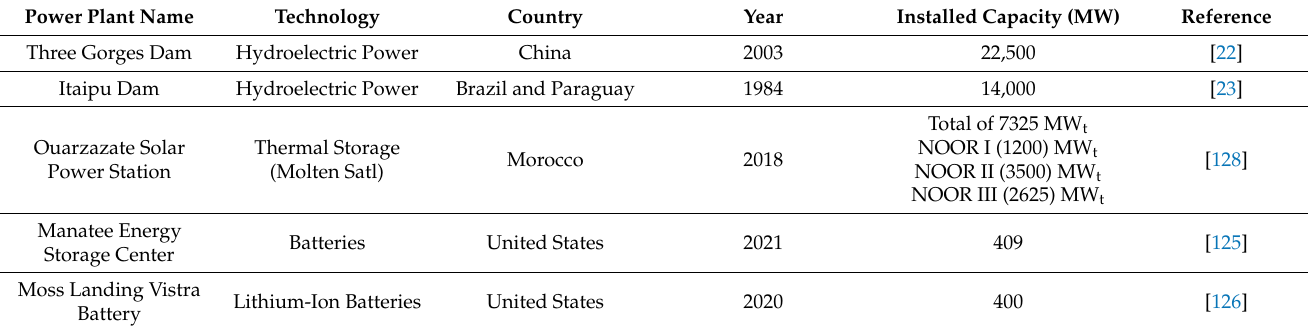
Table 7. Largest energy storage systems projects around the